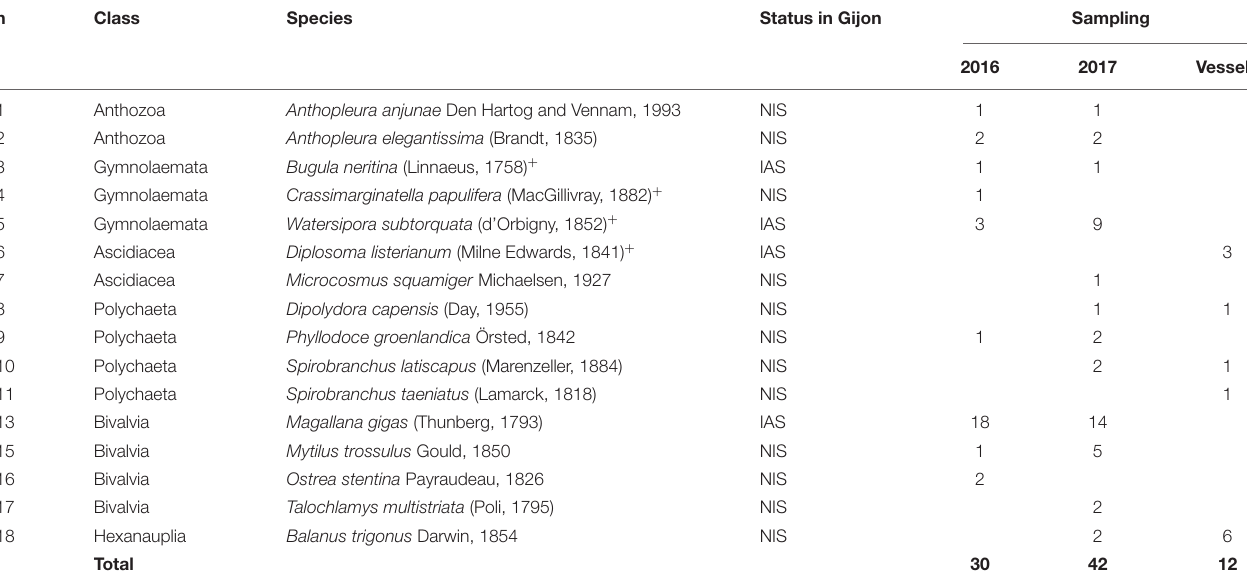
TABLE 2 | The number of non-indigenous (NIS) and invasive (IAS) specimens observed in macroinvertebrates samplings conducted in two consecutive years (2016, 2017) in the port of Gijon, Bay of Biscay, Spain.